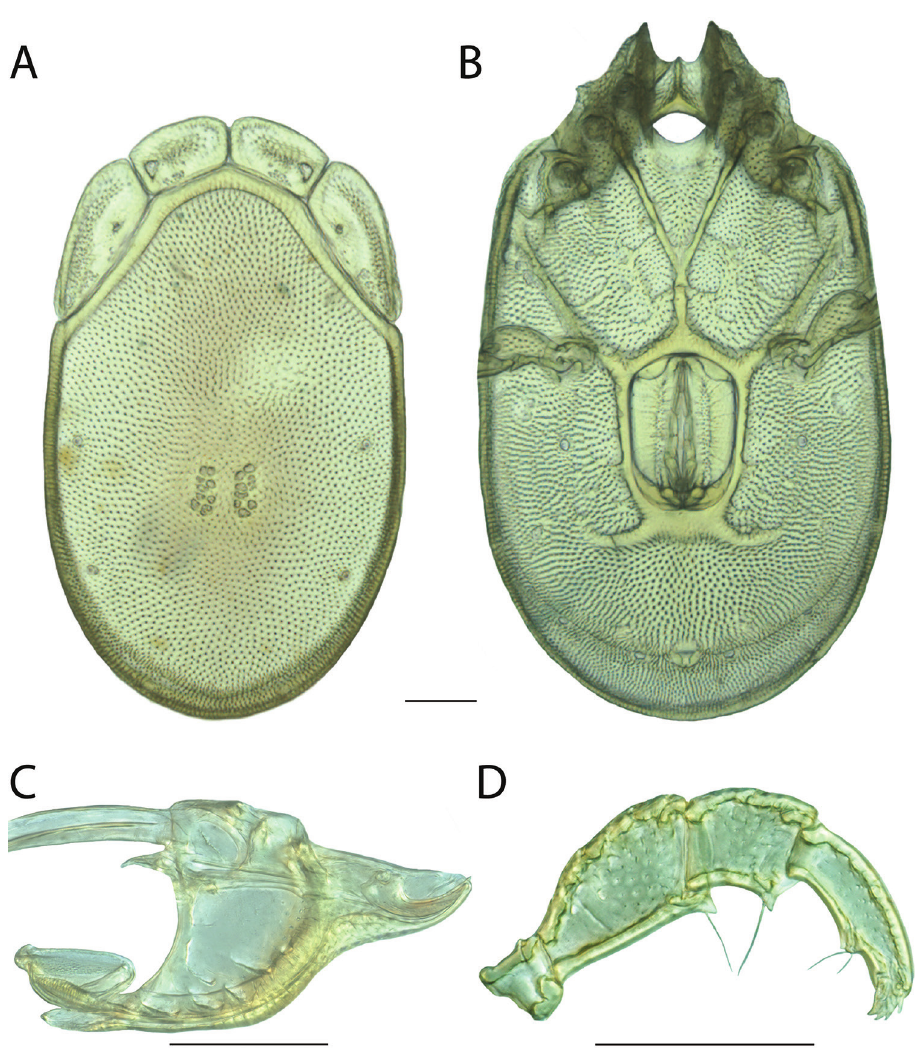
Figure 66. Torrenticola ellipsoidalis male: A dorsal plates B venter (legs removed) C subcapitulum D pe- dipalp (setae not accurately depicted). Scale = 100